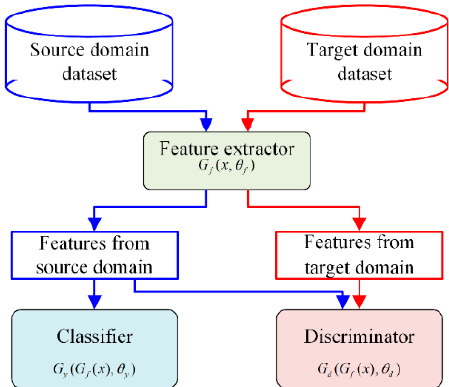
Figure 2. The schematic of the DACNN.